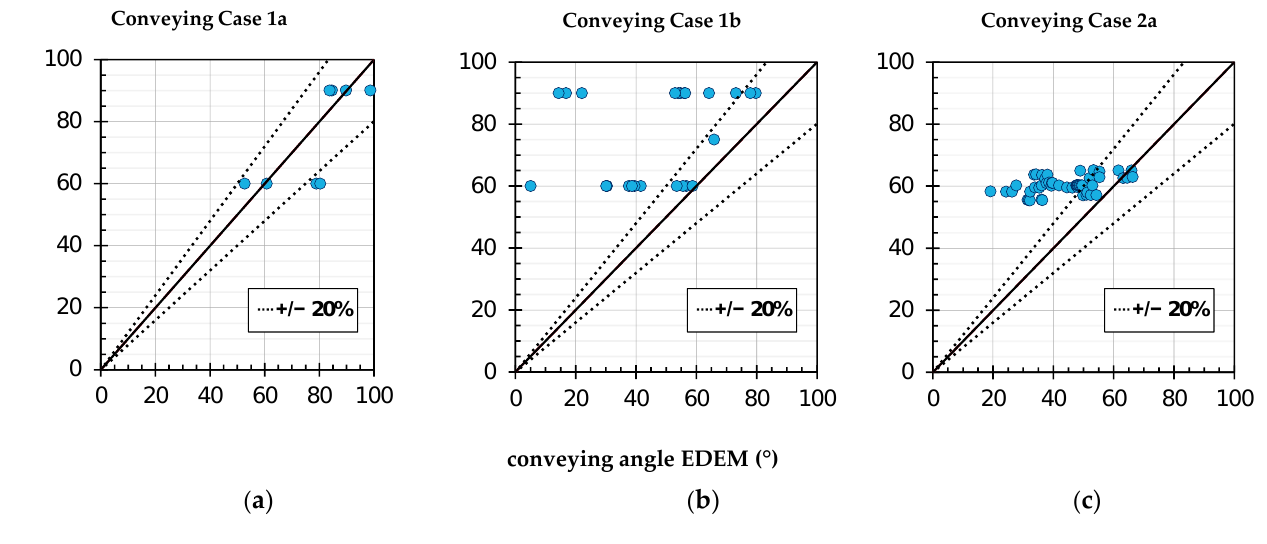
Figure 7. Conveying angle from the analytical calculation according to Bornemann plotted against the conveying angle from the EDEM simulations, sorted by conveying cases 1a, 1b and 2a.